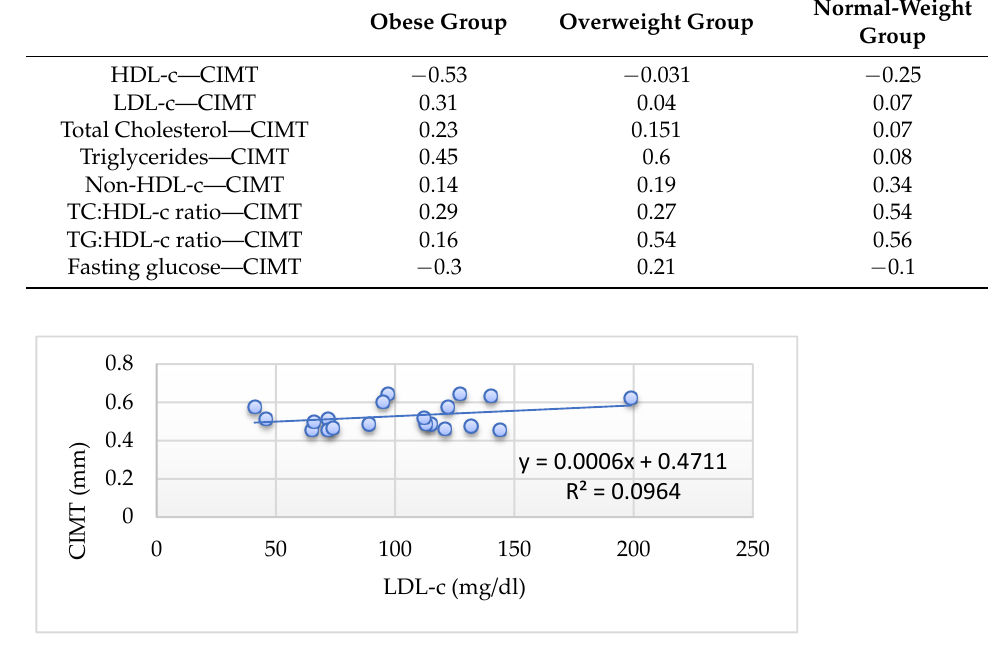
Figure 8. Correlation between CIMT and LDL-c in obese children.